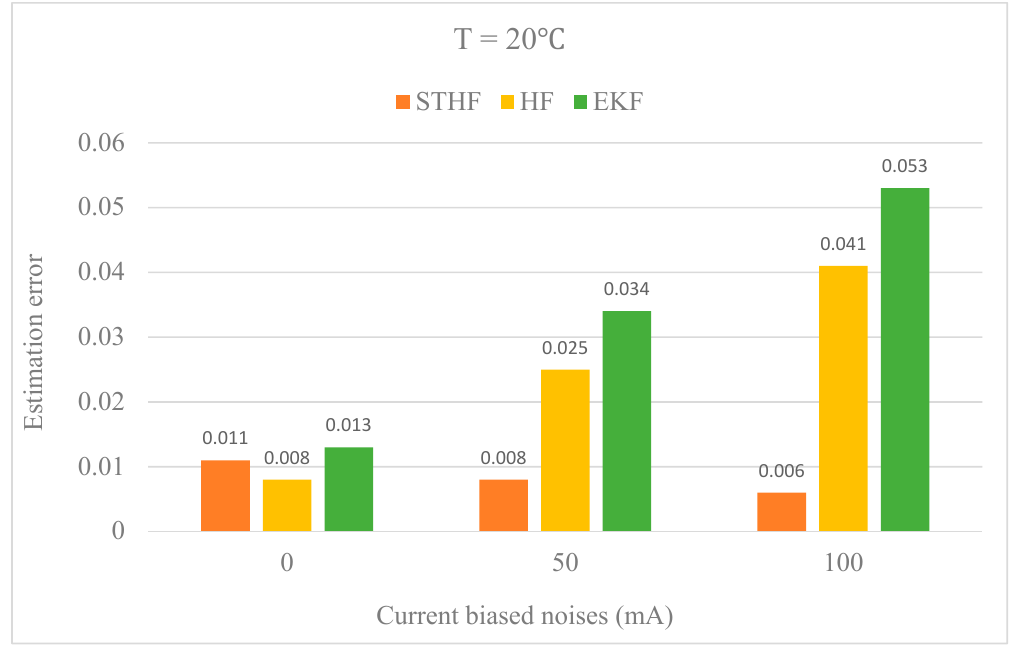
Figure 13. Mean absolute errors of STHF, HF, and EKF at 20 °C.